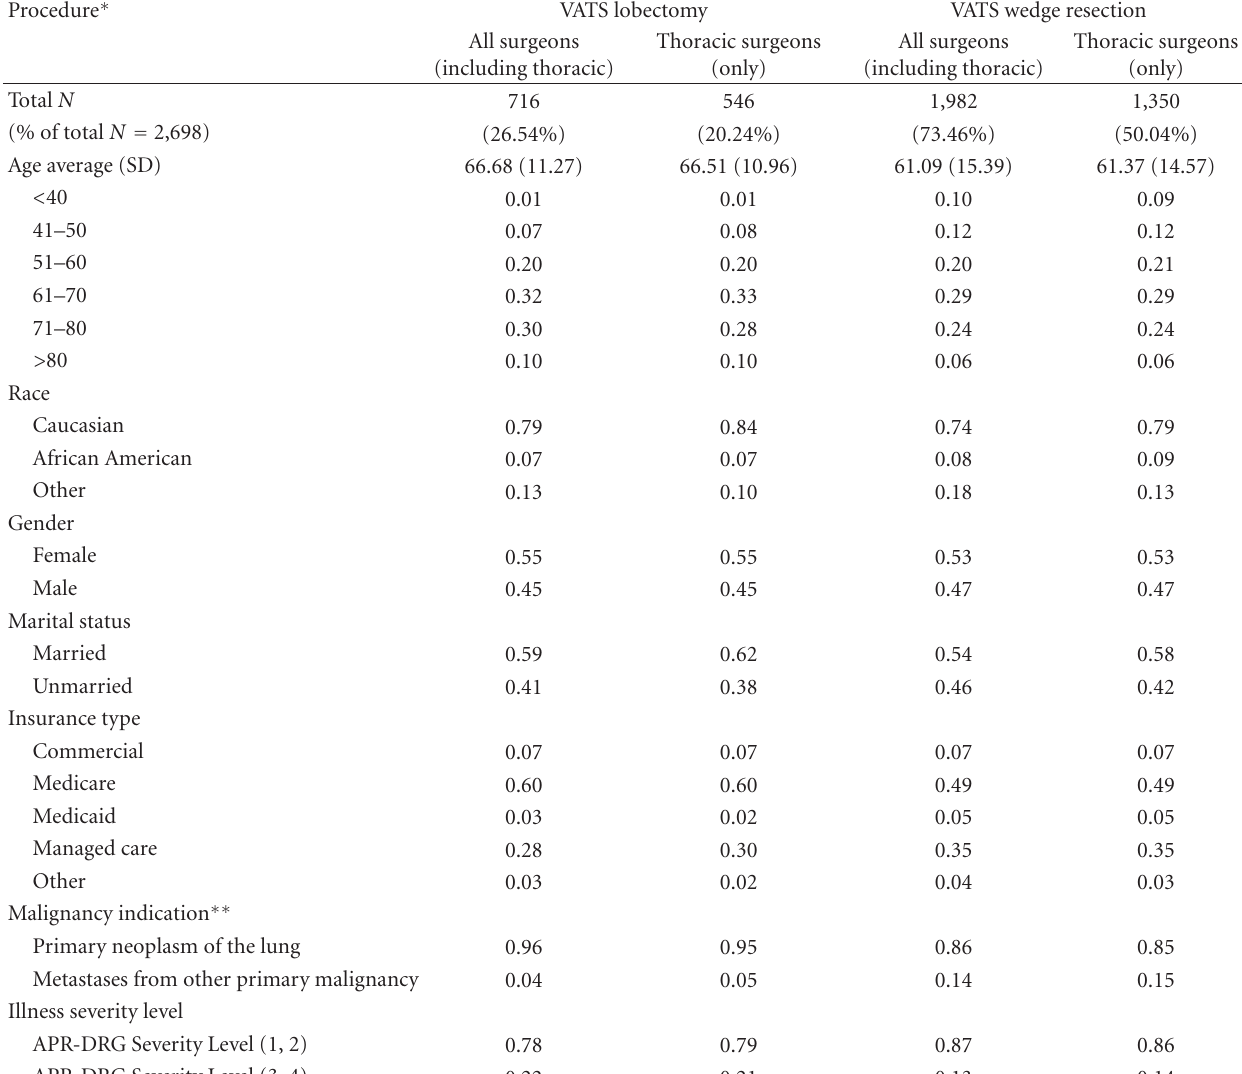
Table 1: Patient